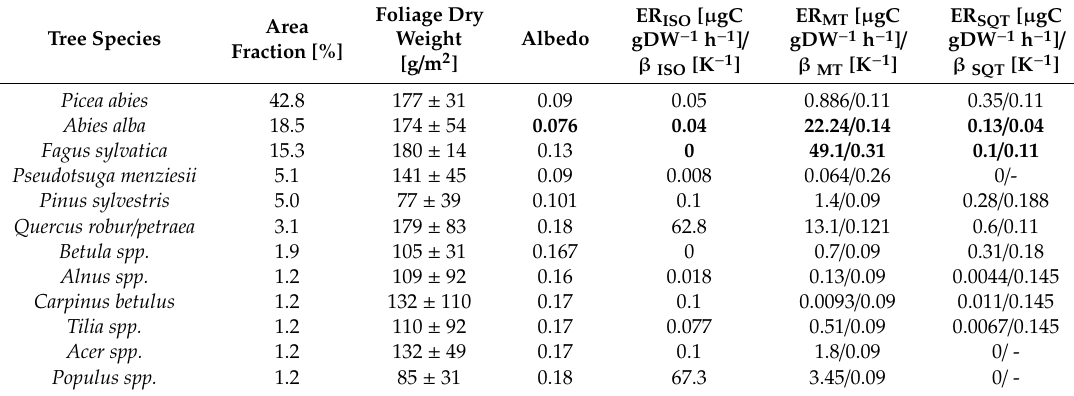
Table 1. Tree species’ information for the Black Forest used for model estimates on the regional scale. Species and regionally averaged foliage biomass originate from Kändler and Cullmann [33] and the Forest Research Agency, Freiburg (pers. com.). Albedo and emission parameters (standard emission rate ER per dry weight (DW) for isoprene, monoterpenes, and sesquiterpenes, as well as temperature response β ) were taken from Bonn et al. [24] (except bold numbers that were determined in this study). Foliage Dry Area Tree Species Weight Albedo Fraction [%] [g / m 2 ]